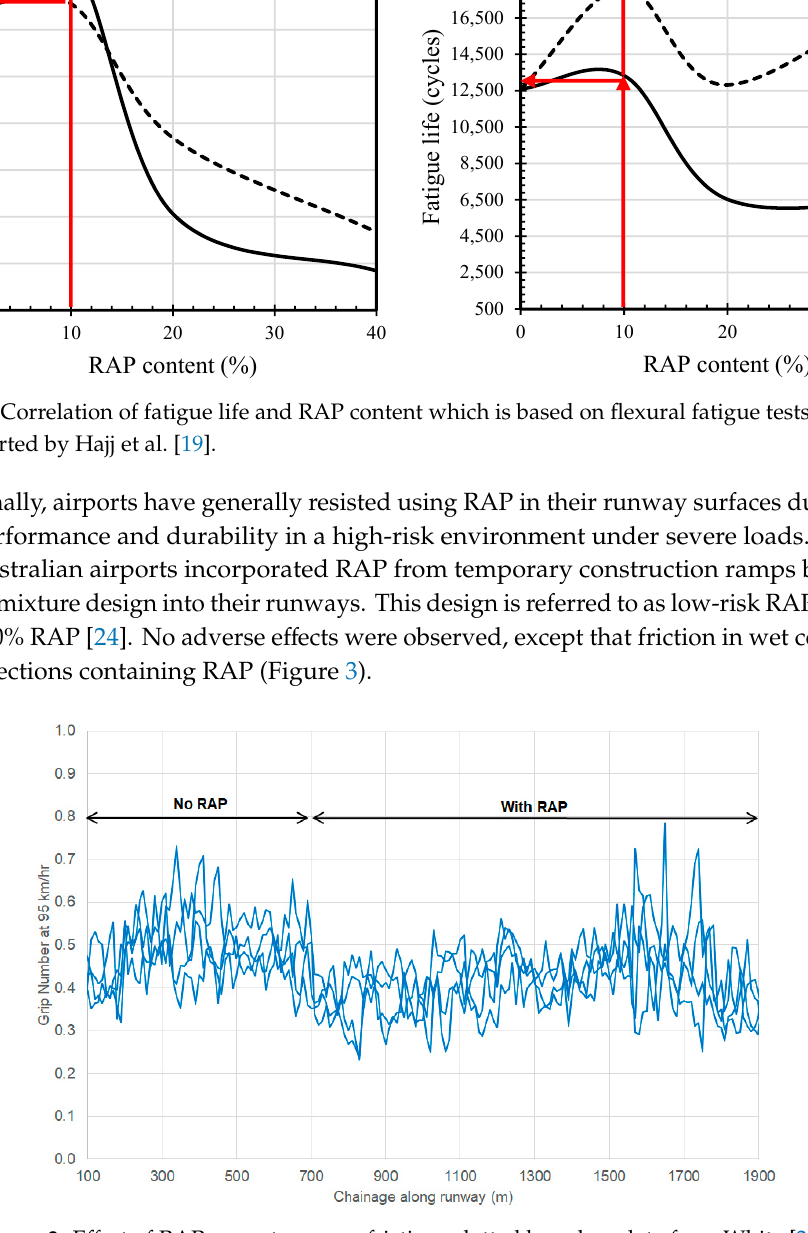
Figure 3. E ff ect of RAP on wet runway friction, plotted based on data from White Figure 3. Effect of RAP on wet runway friction, plotted based on data from White [24].